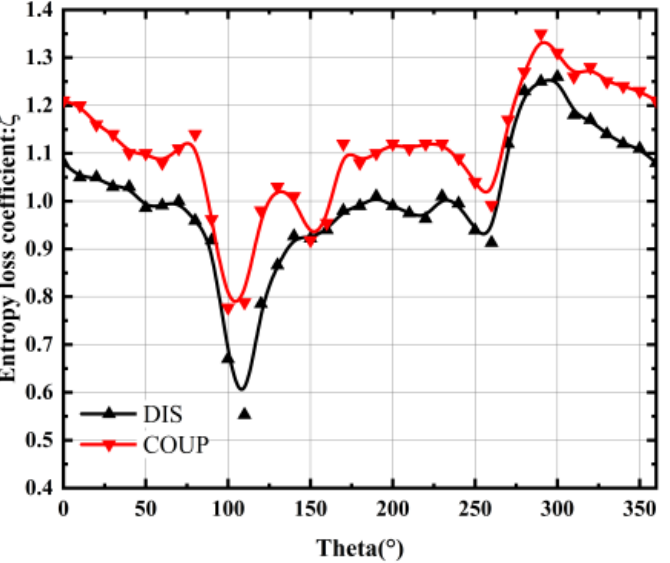
Figure 15. Comparison of the circumferential distribution of entropy loss coefficient at 95% spanwise location.